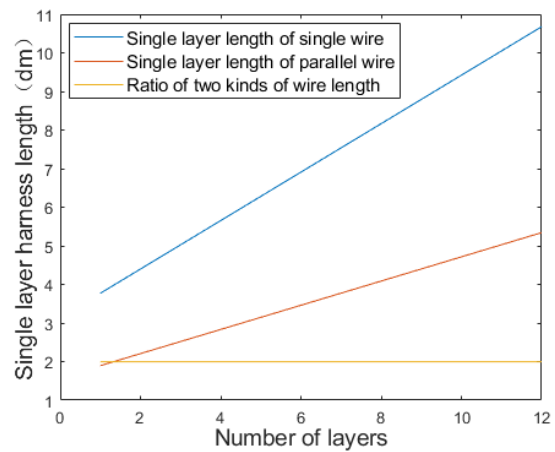
Figure 4. Cylinder expansion length of different coil forms.